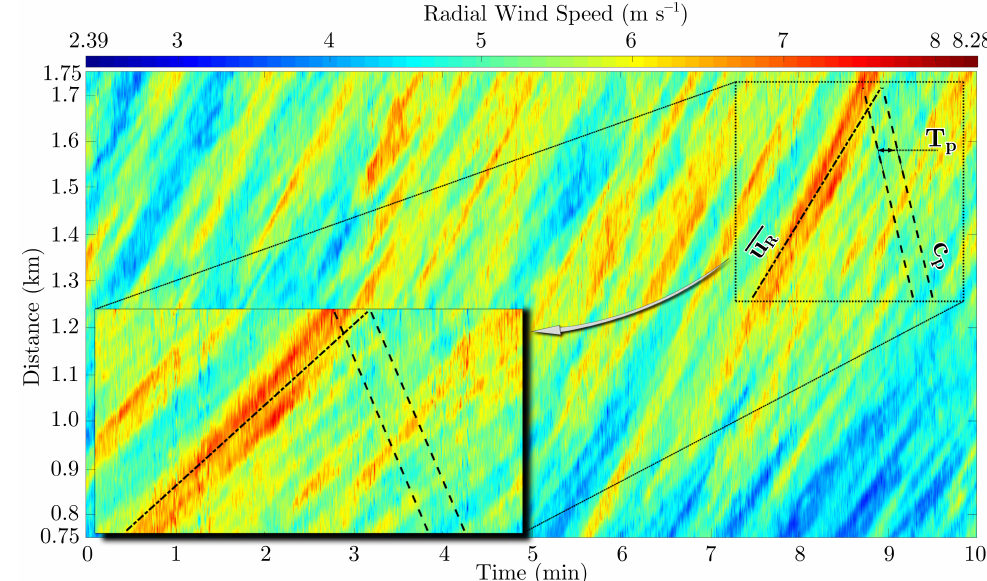
Figure 8. RWS contours for Case 02b. Mean RWS and peak wave phase velocity slopes as dash-dotted and dashed lines, respectively. Dashed lines are at a distance of T p .